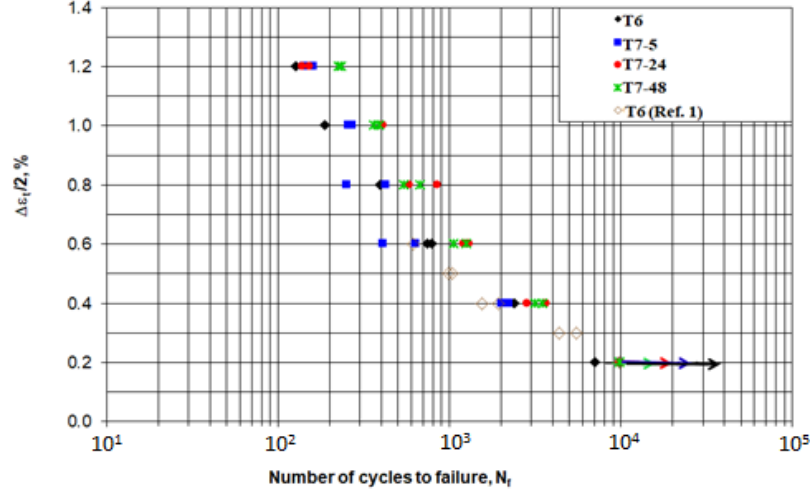
Figure 9. Total strain amplitude vs. number of cycles to failure under various aging conditions.